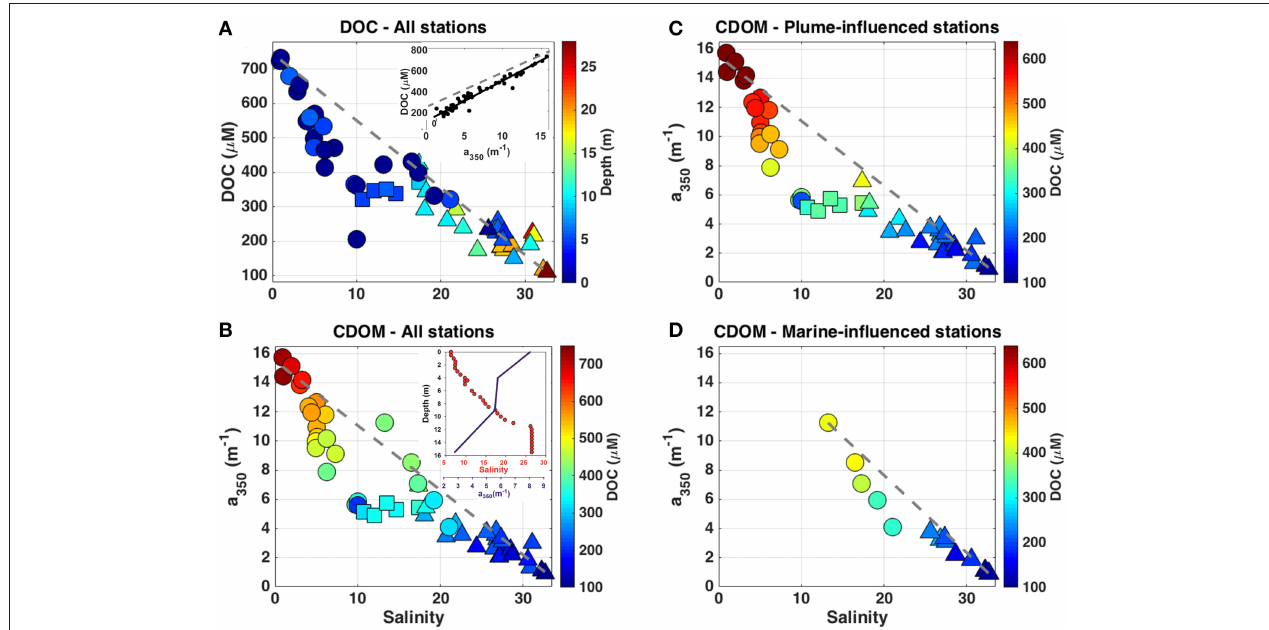
FIGURE 2 | (A) DOC ( µ M) against salinity and depth for all the samples related to this study (m; colorbar). (B) a 350 (m − 1 ) against salinity and DOC for the entire dataset used in this study ( µ M; colorbar), which was split into two subsets regard to the hydrographical conditions: the plume-influenced stations (C) and the marine-influenced stations (D) that are plotted against salinity and DOC ( µ M; colorbar). In all the plots, samples above the pycnocline are displayed as circles, samples at the pycnocline as squares, and samples below the pycnocline are displayed as triangles. Gray dashed-lines indicate the hypothetical conservative mixing line between DOM (or DOC) and salinity. Inset graph in (A) shows the relationship between a 350 (m − 1 ) and DOC ( µ M) and the dashed line shows the fit exhibited for the coastal Canadian Arctic (Walker et al., 2009). Inset graph in (B) exhibits vertical distribution of salinity (red dots) and a 350 (m − 1 ; blue line) for one typical plume-influenced